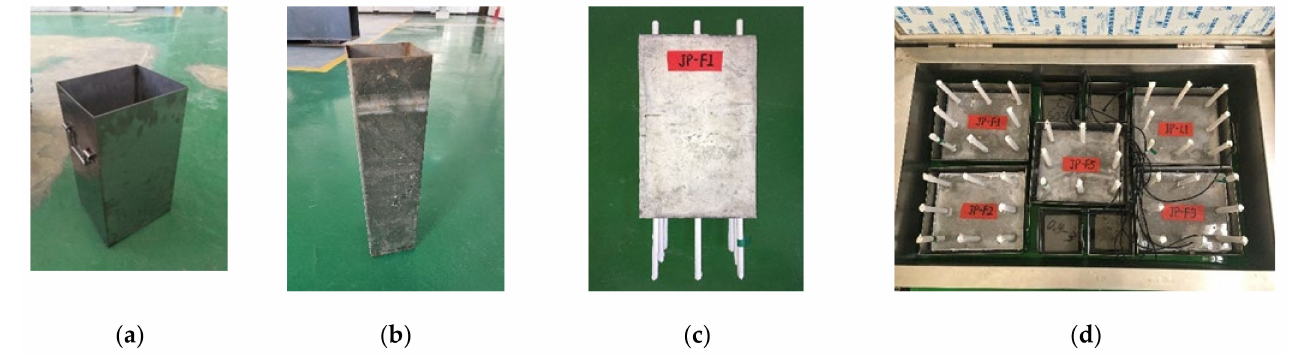
Figure 17. Rapid freeze–thaw cycle test for the F-T segments. ( a ) Freeze–thaw cycle container. ( b ) Constant temperature container. ( c ) Rust prevention. ( d ) Inside the testing machine. The thawing and freezing temperatures of the concrete rapid freeze–thaw cycle testing machine were set to 5 ◦ C and − 20 ◦ C, and the test was started. The time of a single freeze–thaw cycle was not more than 4 h. The thawing time of the specimen accounted for less than one-fourth of the time of a single freeze–thaw cycle. Taking 25 freeze–thaw cycles as the test cycle, the segments were taken out after the freeze–thaw cycles. The results of the seawater freeze–thaw cycle test on each segment are shown in Figure 18.